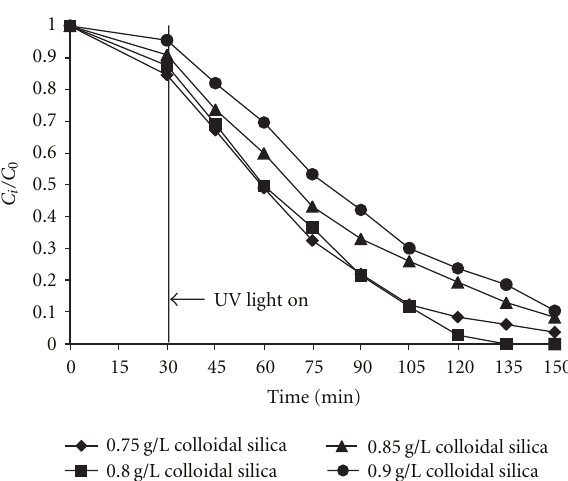
Figure 7: Photocatalytic degradation of aqueous phenol solution at di ff erent colloidal silica loading. Conditions: TiO 2 nanotubes and silica gel in the catalyst were 0.12 and 0.08g/L, respectively, air flow rate = 0.3L/min, initial phenol concentration = 30 mg/L, and medium pH =